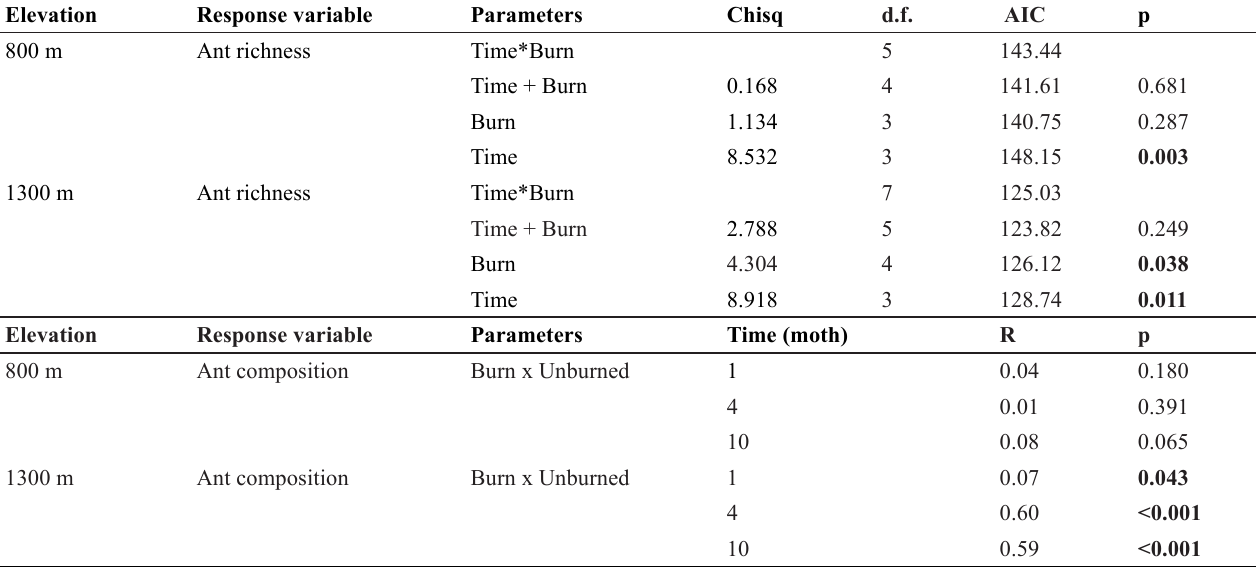
Table 1 . Values of linear mixed effects model of burning and time since fire effects on ant species richness in campos rupestres at two altitudes (800 and 1300 m) and NMDS’s values of dissimilarity between burned and unburned plots at each site (Jaccard index), separated by time since fire (in